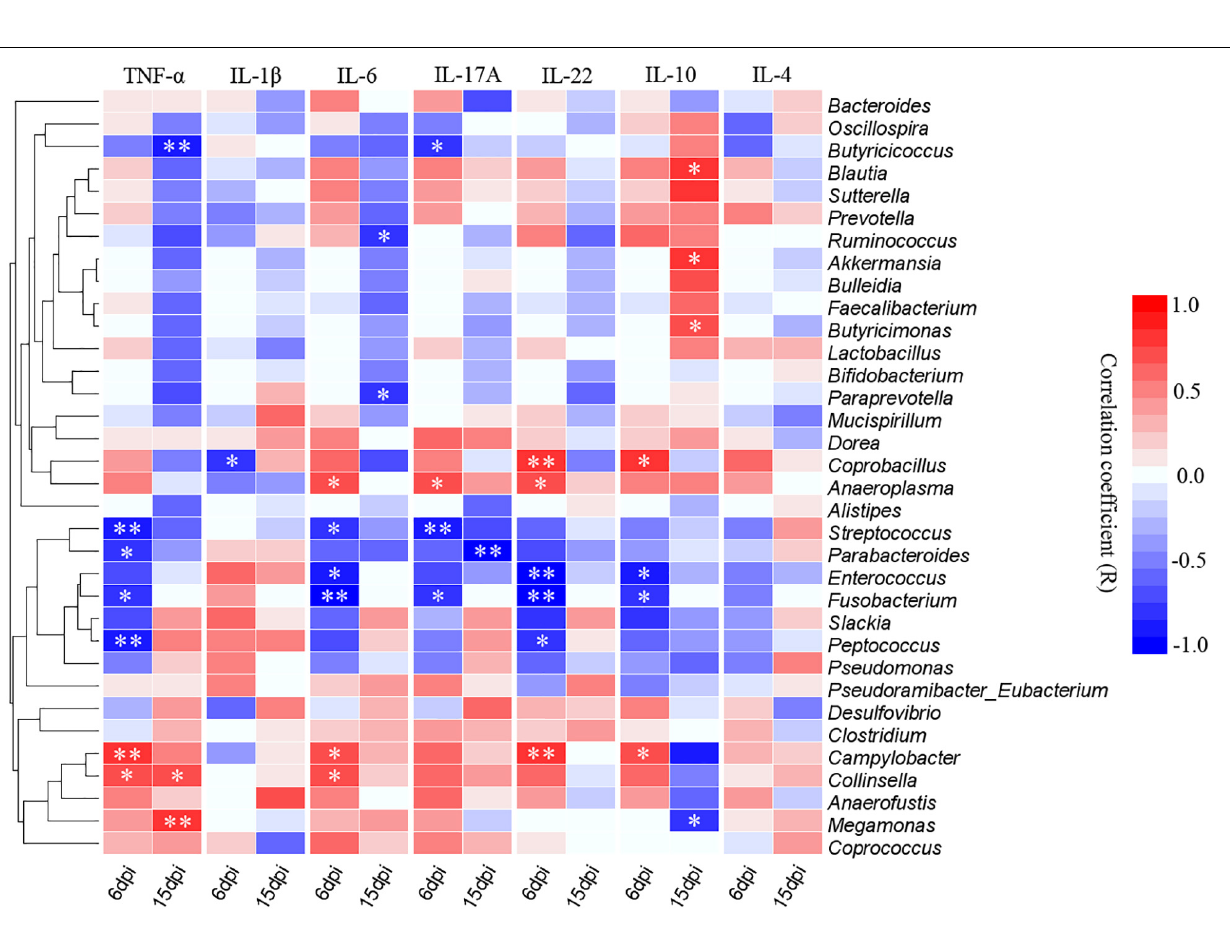
Frontiers in Microbiology |